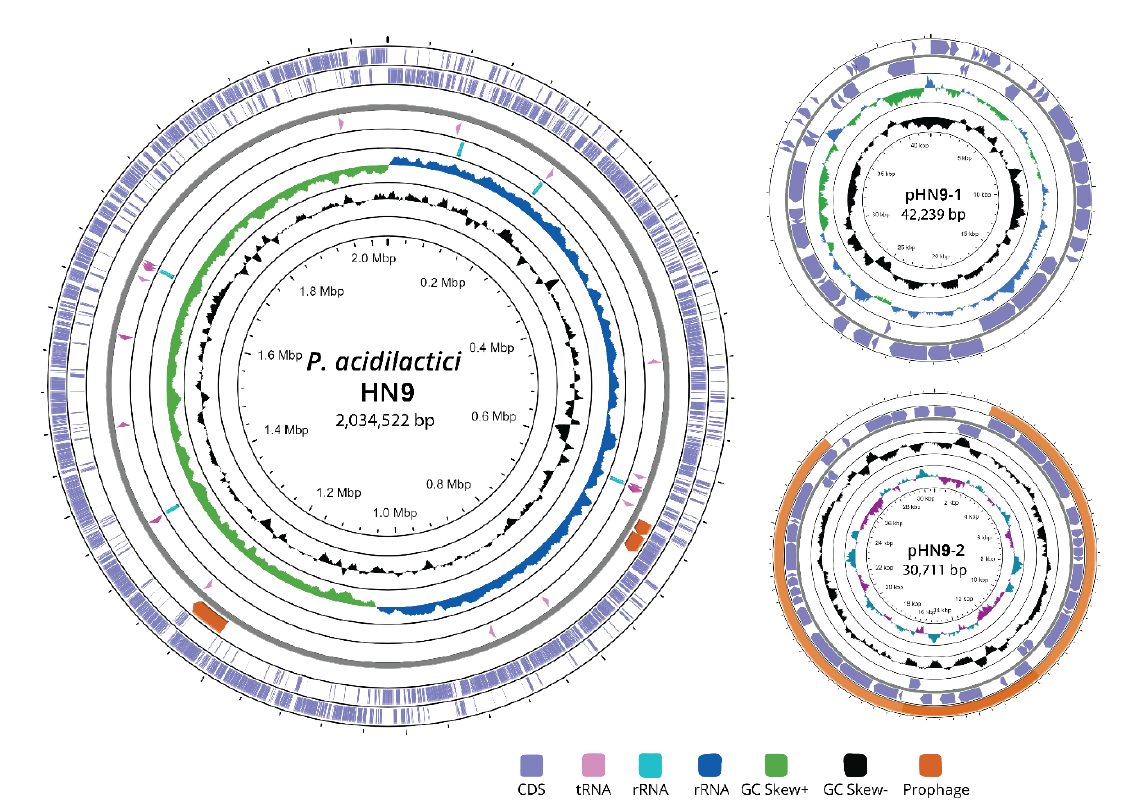
Figure 1. Circular genome and plasmid representations of P. acidilactici HN9. The circular illustrations were visualized using the CGView server beta version and contain seven rings. The outermost circle and the second circle show the positions of the CDSs in forward and reverse strand directions, respectively. The next rings show the following information: prophage regions, tRNA, rRNA, GC content, GC skew+, and GC skew-, respectively. Table 1. Genomic features of P. acidilactici